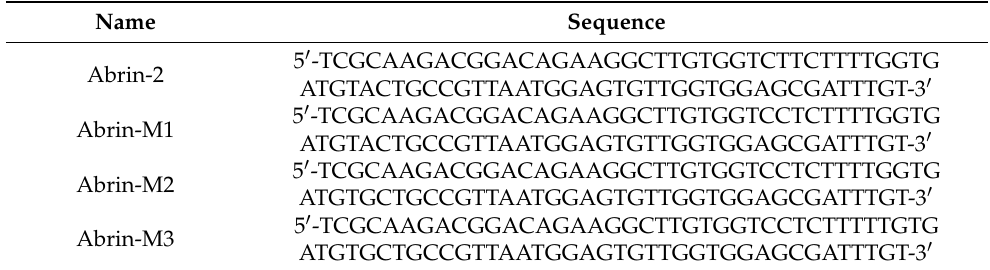
Table 1. The sequence of three new aptamers.